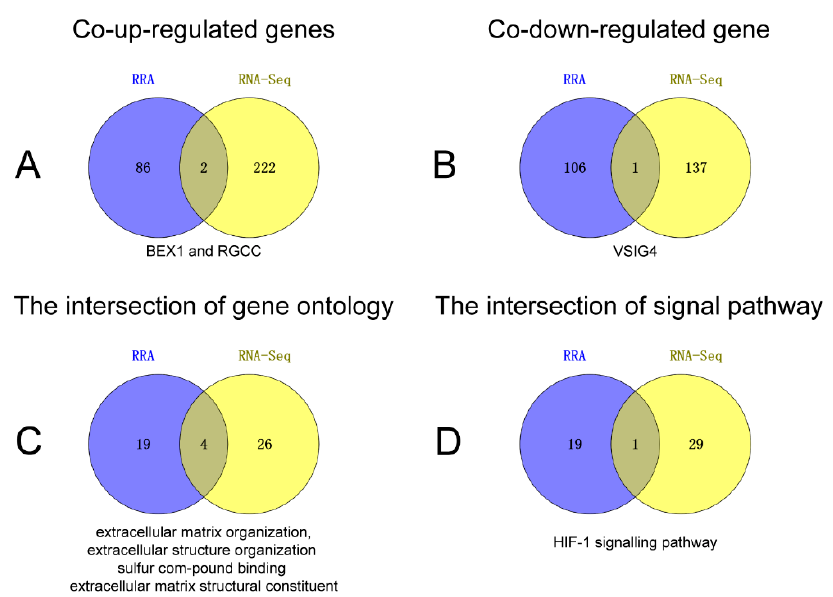
Figure 6. The Venn diagram indicating the intersection of RRA and RNA-Seq analysis results. ( A ) Upregulated genes, ( B ) downregulated gene, ( C ) the intersection of GO, and ( D ) the intersection of KEGG.